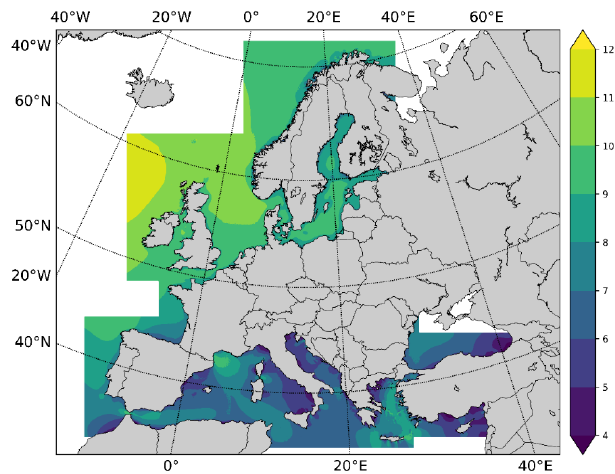
Figure 4. WRF New European Wind Atlas production run mean wind speed (ms − 1 ) at 100m height for 1989 to 2018 with 3km spatial grid